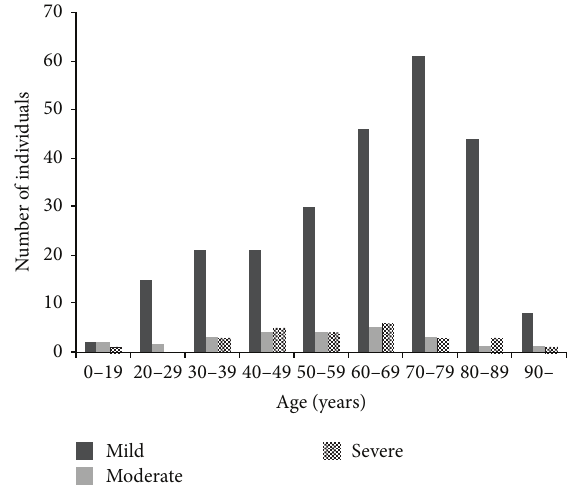
Figure 1: Distribution of severity of brain injury according to age